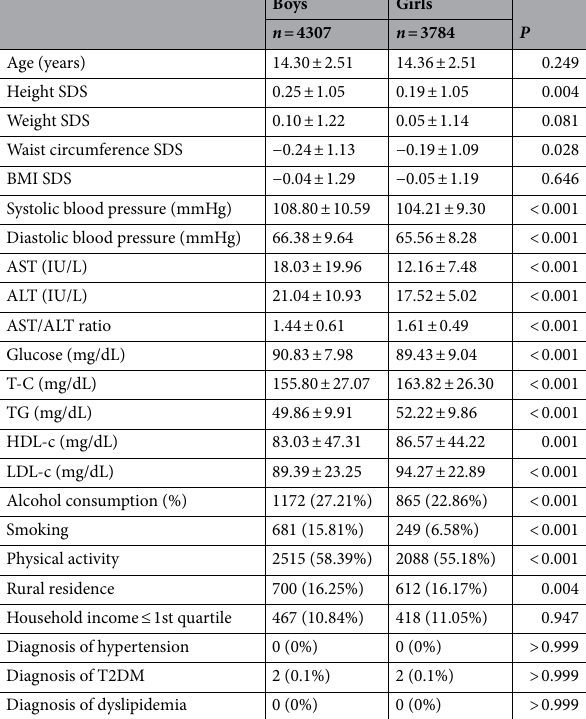
Table 1. Clinical characteristics of boys and girls aged 10–18 years ( n = 8091). Data are presented as the mean ± standard deviation (SD). SDS, standard deviation score; BMI, body mass index; AST, aspartate aminotransferase; ALT, alanine aminotransferase; T-C, total cholesterol; TG, triglyceride; HDL-c, high-density lipoprotein cholesterol; LDL-c, low-density lipoprotein